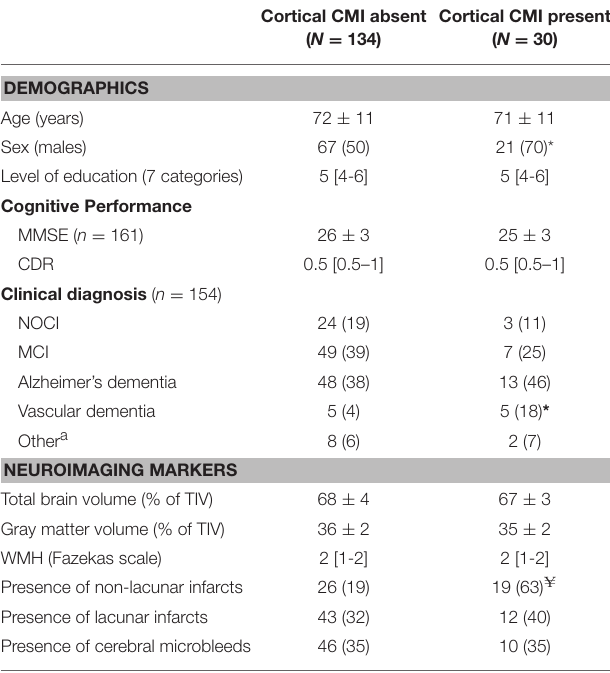
TABLE 1 | Characteristics of patients with and without cortical